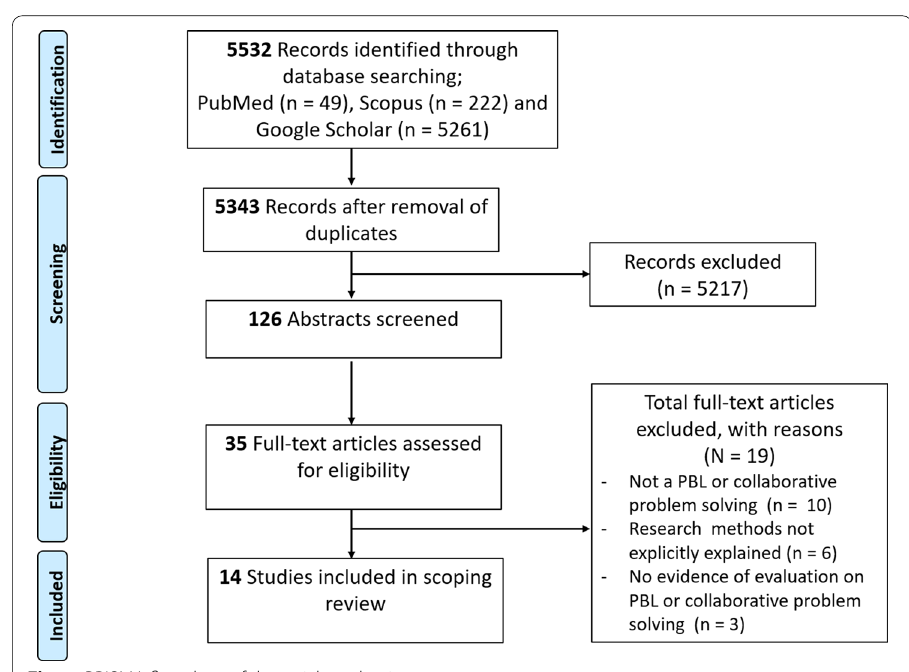
Fig. 1 PRISMA flowchart of the articles selection